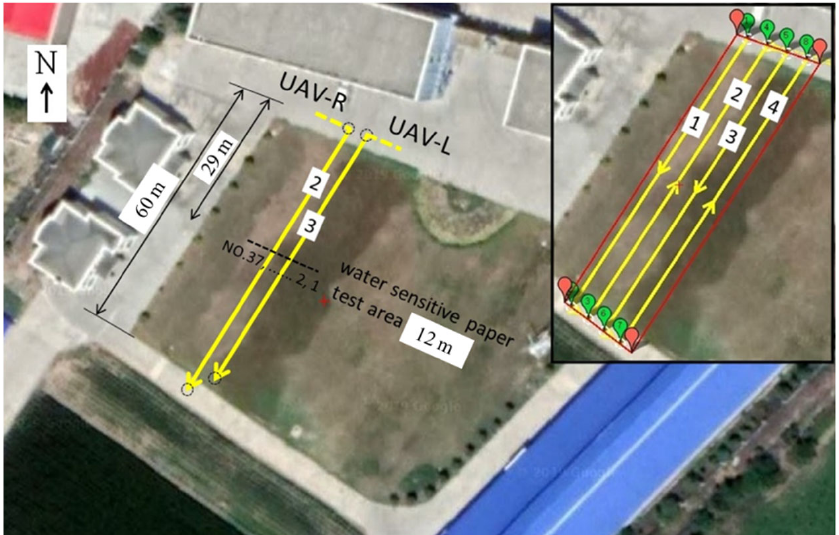
Figure 12. Path planning in the ground station software. The flight height of the two UAVs was set to 3 m and the water ‐ sensitive papers (WSPs) were clamped on the clips at a height of 0.5 m above the ground. Therefore, the actual height from the nozzles to the water sensitive papers was approximately 2.5 m, which represents the operational height above the crop canopy. The flying speed was set to 3 m/s and 5 m/s as the representatives of low ‐ speed and high ‐ speed spraying applica ‐ tions, respectively. 2.4.2. Experiment Design A total of 18 sets of outdoor experiments were carried out. There were six simultane ‐ ous spraying tests and three sequential spraying tests at each flying speed, which are num ‐ bered and summarized in Tables 1 and 2. To facilitate the analysis of the test results, sim ‐ ultaneous spraying was divided into short ‐ interval simultaneous spraying and long ‐ in ‐ terval simultaneous spraying, according to the time difference t between two UAVs as explained in Section 2.1 We took side ‐ view and front ‐ view videos for all flight experi ‐ ments (Figures 13 and 14). The time difference t between the two UAVs in the forward direction listed in Table 1 was obtained by watching the aerial spraying videos (side view)